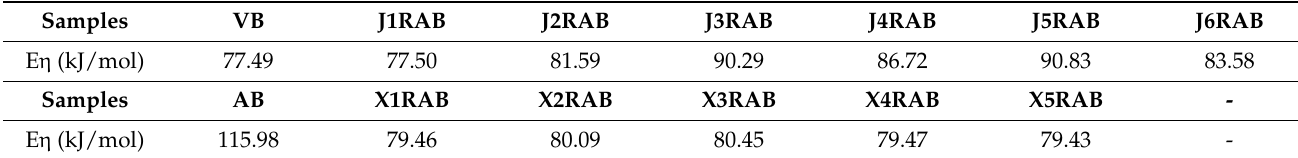
Table 8. Viscous activation energy of aged and rejuvenated